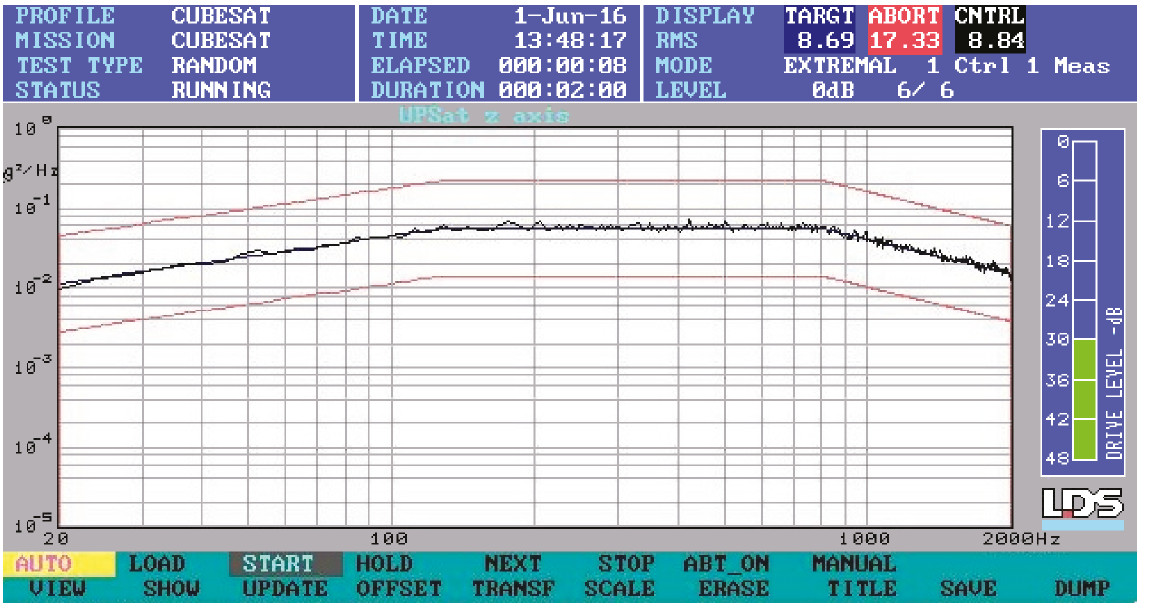
Figure 15: PSD response ( z